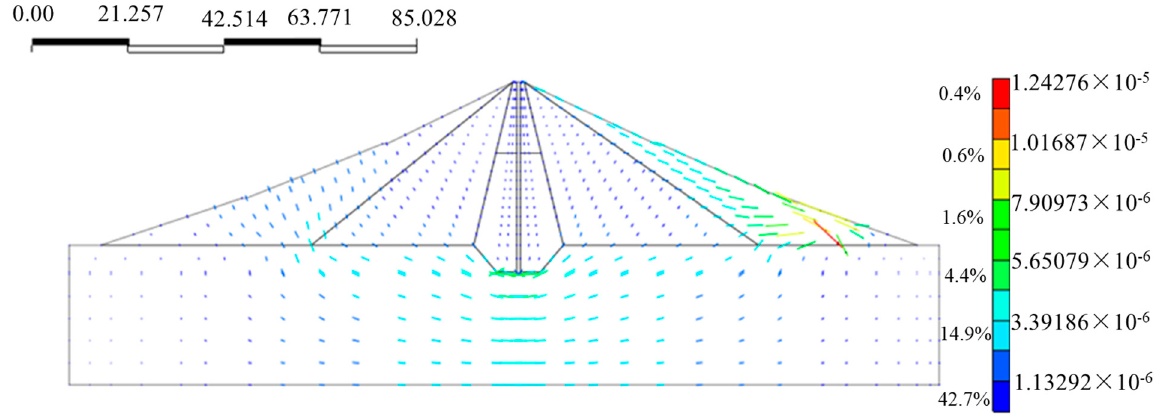
Figure 12. Velocity vector diagram of the checking flood level by the proposed method.